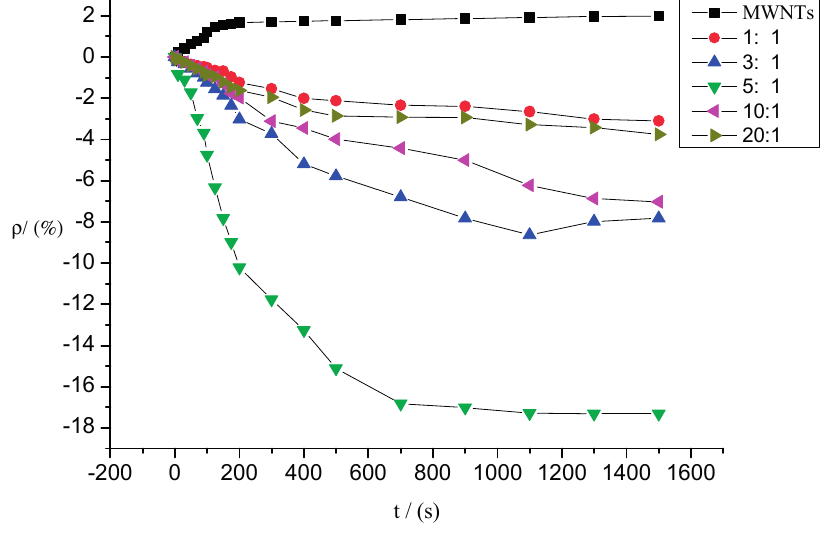
Figure 10. Response of MWNT sensor to SO 2 F 2 at 100 ppm